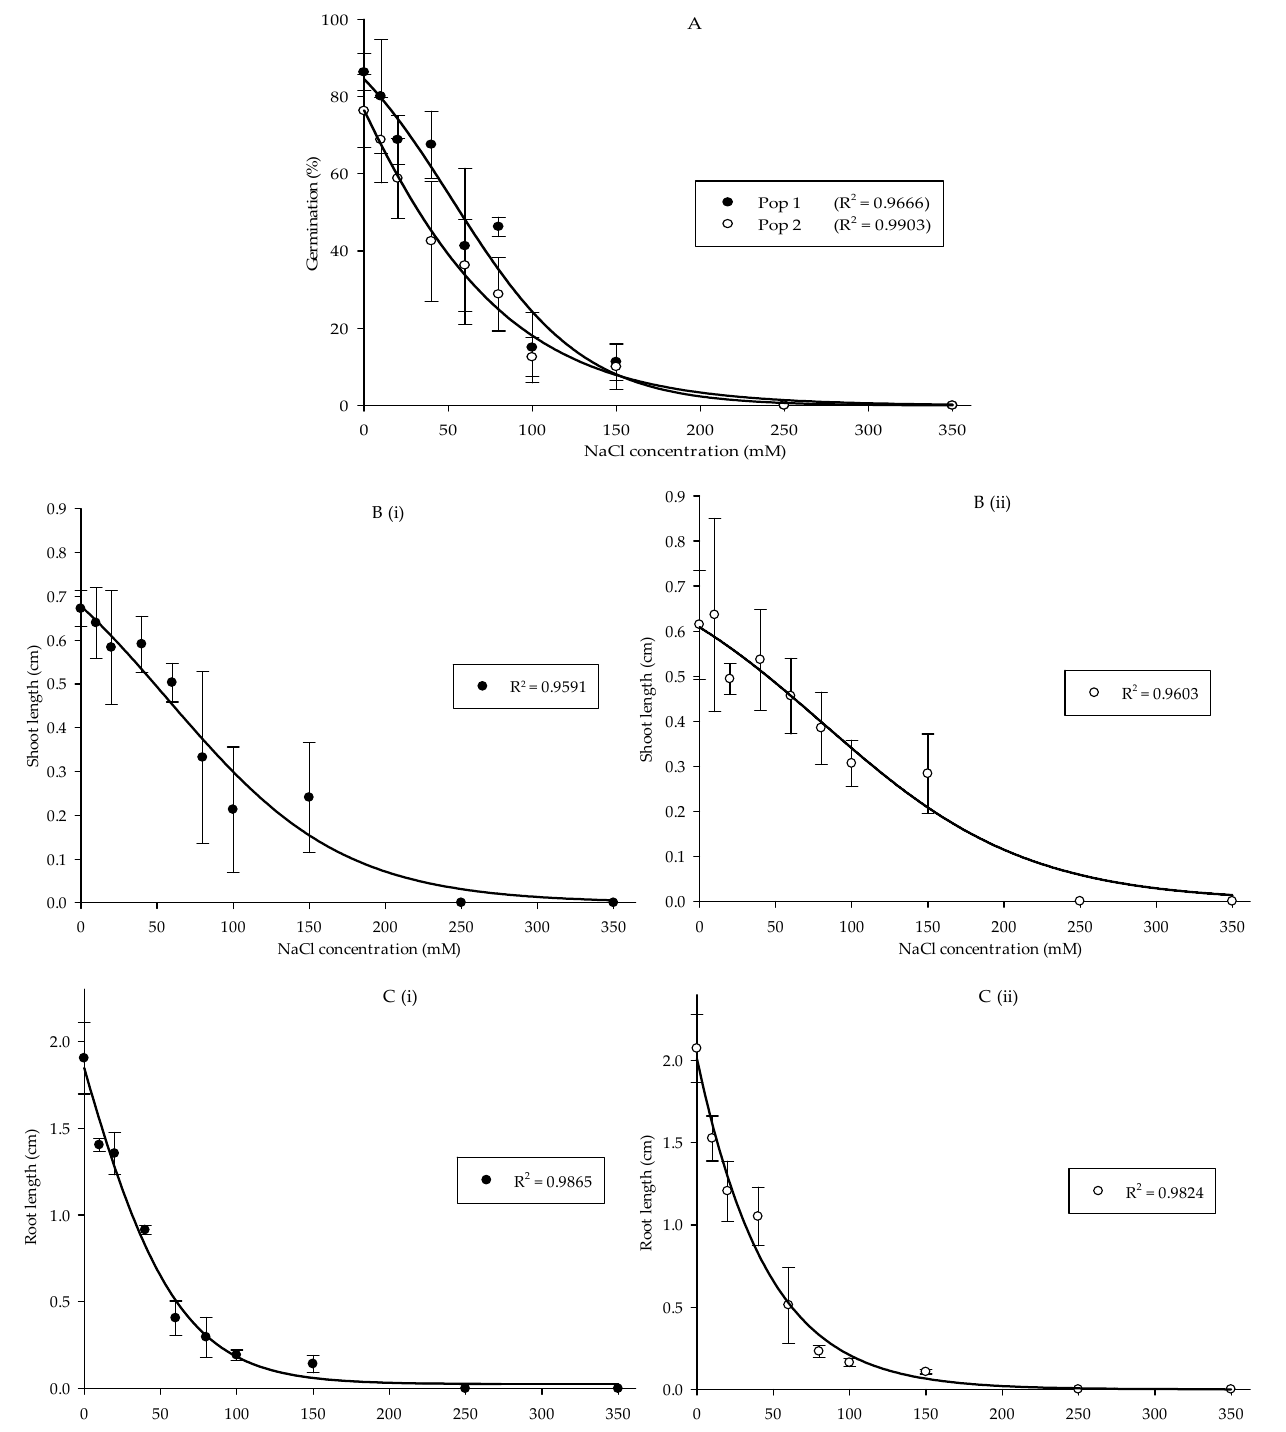
Figure 2. Percentage of seed germination of Pop 1 and Pop 2 ( A ), shoot length of Pop 1 ( Bi ) and Pop 2 ( Bii ), and root length of Pop 1 ( Ci ) and Pop 2 ( Cii ) of Parthenium weed under different salinity treatments.